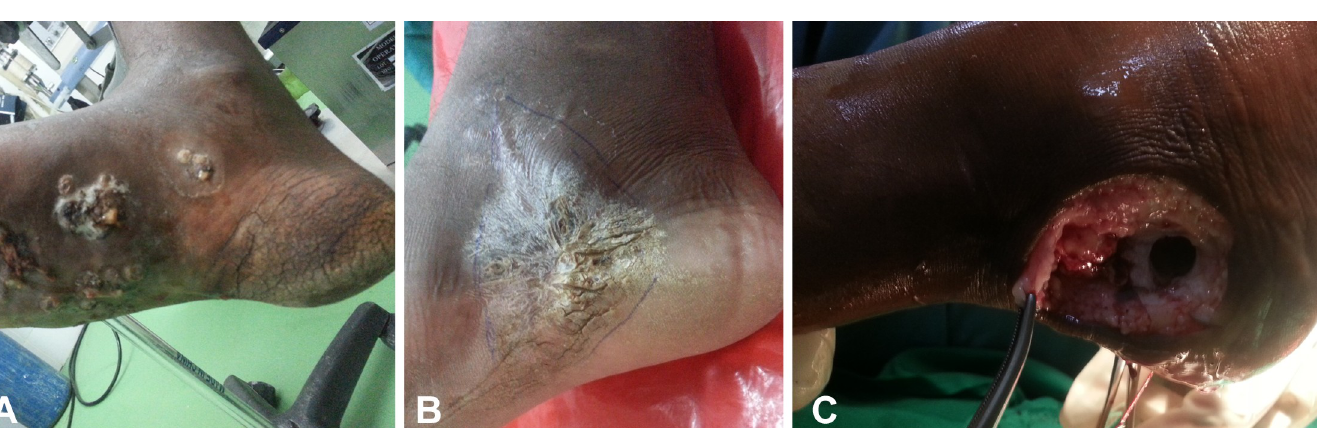
Bone involvement, mycetoma relapse and positive family history were recorded in 21% (n = 25), 12% (n = 14) and 12% (n = 14) of cases, respectively. Black-grain mycetoma constituted 93.3% (n = 111/119) of the cases, 76.6% (n = 85/111) were from Gezira State and distributed among the eight localities. Highest number of cases was from South El Gezira: 30.6% (n = 26/85) and from Um Elqura: 27.1% (n = 23/85), while El Managil showed the lowest rate with 2.4% (n = 2/85). Black-grain mycetoma cases from Sinnar State were 23.4% (n = 26/111) and came from two localities: East Sinnar 76.9% (n = 20/26) and Sinnar 23.1% (n = 6/26) (Fig 4).